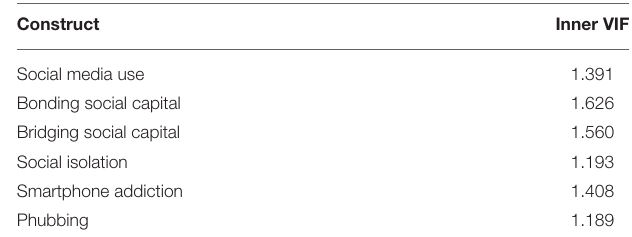
TABLE 2 | Common method bias (full collinearity